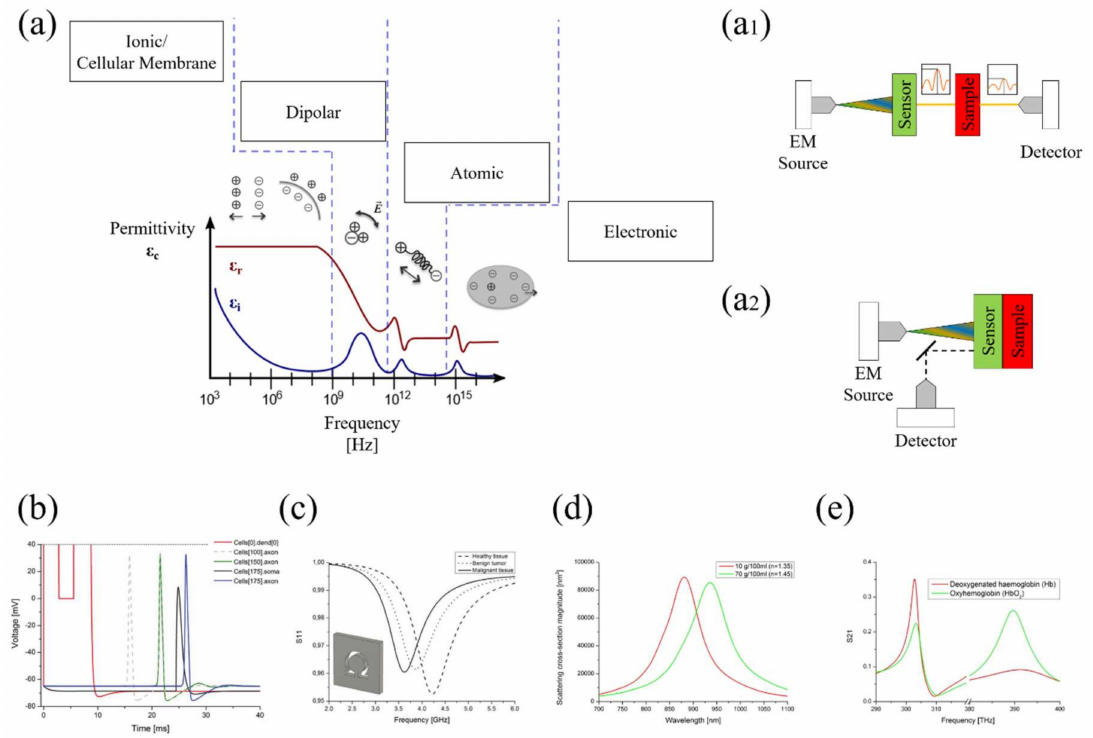
Figure 3. ( a ) Biological material permittivity spectrum over frequency: ε r and ε i denote the real and the imaginary part of the permittivity, respectively. Various processes arise as a function of frequency: ionic and dipolar relaxation, atomic and electronic resonances at higher energies. There are two kind of sensing platforms: ( a 1 ) Direct contact and ( a 2 ) Distance measurements. ( b ) Pulse propagation along dendride 0 of neuron 0 (red line), axon of neuron 100 (gray dashed line), axon of neuron 150 (green line), target neuron soma (black line) and target neuron axon (blue line) [71]; ( c ) Resonant frequency shift among healthy tissue (step-line), benign tumor (dot) and malignant tissue (straight line); ( d ) Extinction cross-section spectra for glucose concentration measurements; and ( e ) transmission spectra for Oxyhemoglobin and Deoxygenated hemoglobin at reference absorption frequencies